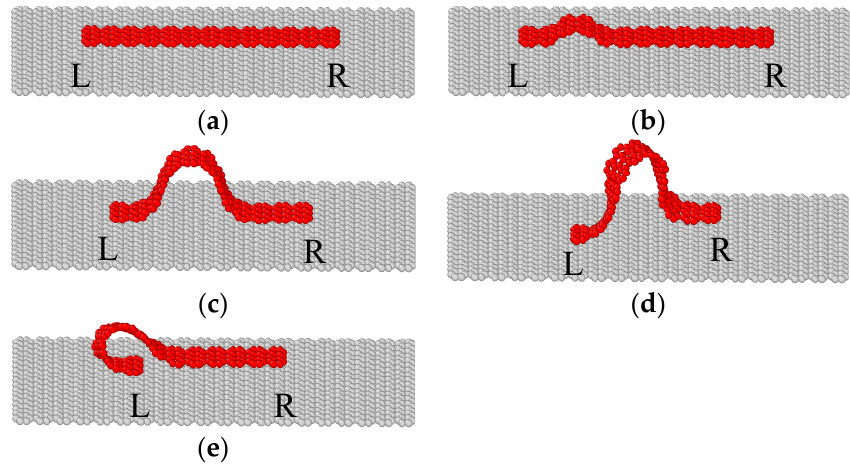
Figure 5. Configurations of the graphene sheet at points A–E of the curve in Figure 4. ( a ) Δ u x / l = 1.85%; ( b ) Δ u x / l = 2.59%; ( c ) Δ u x / l = 23.72%; ( d ) Δ u x / l = 44.00%; ( e ) Δ u x / l = 44.11%.